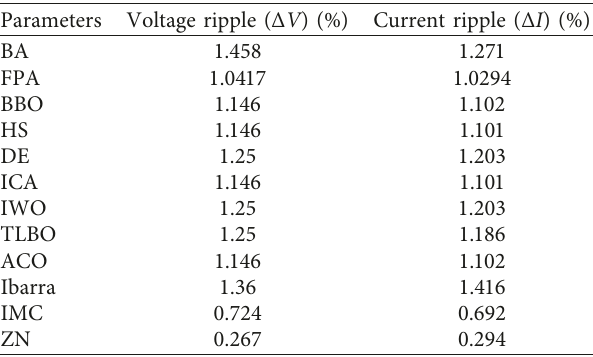
Figure 14: Plot for output current and voltage ripple for varying load case using flower pollination algorithm-tuned QFT controller. Table 4: Convertor performance parameters (variable load).